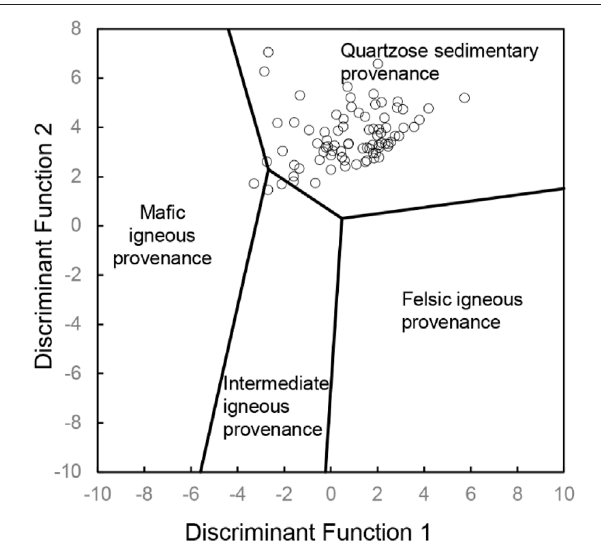
FIGURE 6 | Plot of the provenance discrimination diagram of Roser and Korsch (1988) for the studied mudstones. The Al-normalized version of the diagram of Roser and Korsch (1988) was adopted to avoid dilution effect of non-terrigenous materials. Samples are generally plotted within the “ Quartzose sedimentary provenance ” region, implying a source area of the intercalated mudstoneslocated ina continental interior.Discriminant Function 1: 30.638×TiO2/Al2O3 – 12.541×Fe2O3/Al2O3 + 7.329×MgO/Al2O3 +12.031×Na2O/Al2O3 + 35.402×K2O/Al2O3 - 6.382. Discriminant Function 2: 56.500×TiO2/Al2O3 – 10.879×Fe2O3/Al2O3 + 30.875×MgO/Al2O3 – 5.404×Na2O/Al2O3 + 11.112×K2O/Al2O3 – 3.809.